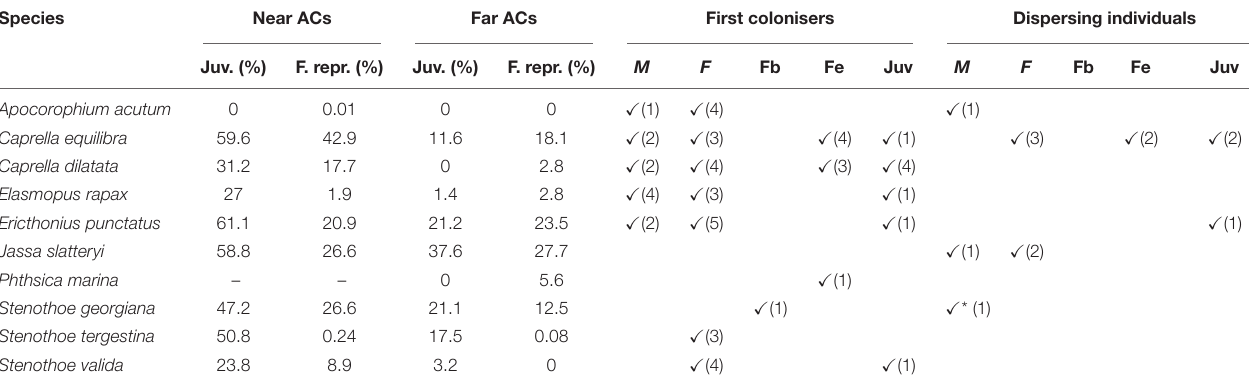
TABLE 3 | Proportion of juveniles and reproductive females present in the artificial collectors (ACs) and sex and life-stage of the first colonisers in an AC and the dispersing habitat detected in this study. Species Near ACs Far ACs First colonisers Dispersing individuals